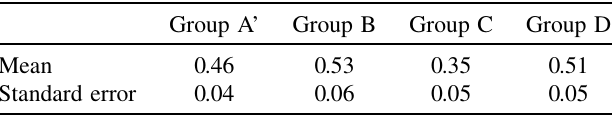
TABLE X. Average physics grades (normalized to 1) for post solutions for the different